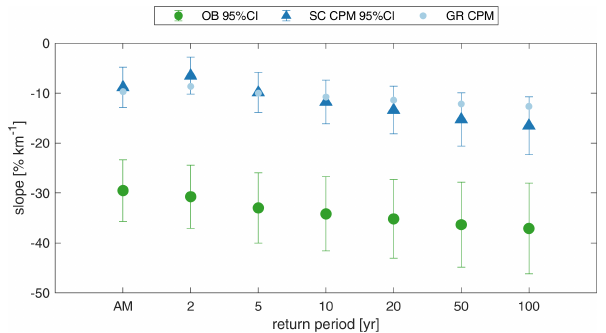
Figure 7. Normalized slope of the relation with elevation for 1h duration annual maxima (AM) and return levels (2, 5, 10, 20, 50, and 100-year return period), for observations (green circle), station- colocated CPM (blue triangle), and grid CPM (light blue circle). All the slope differences are significant. Errror bars indicate 95% confidence interval from 1000 bootstrap